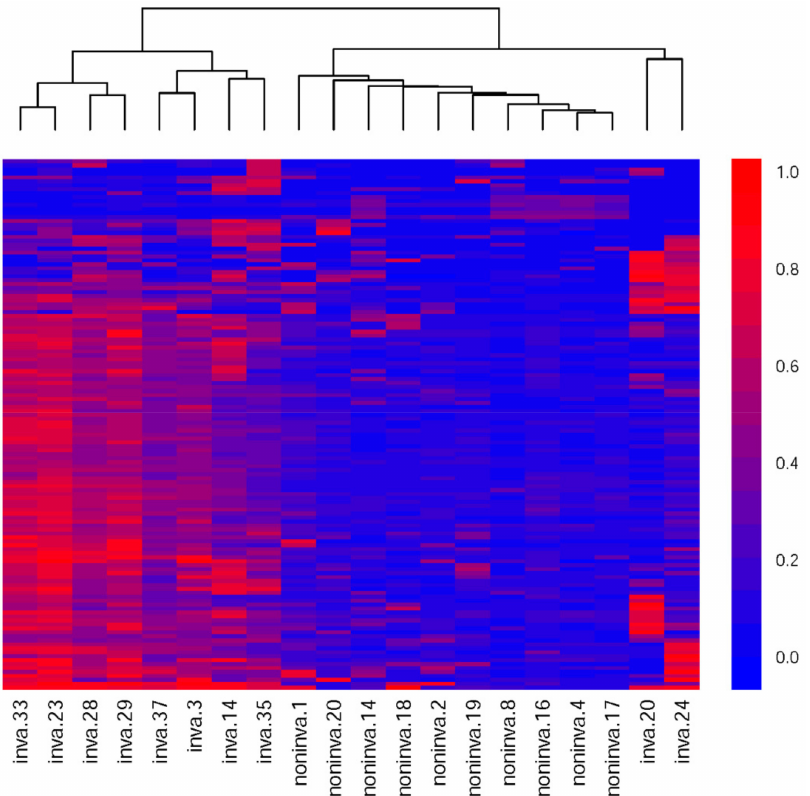
Figure 3. Unsupervised clustering and heatmap of 20 samples based on the 134 di ff erently methylated probes. Each column corresponds to a sample and each row corresponds to a CpG site. Color indicates methylation value. With color ranging from blue to red, methylation values range from small to large. Color key is to the